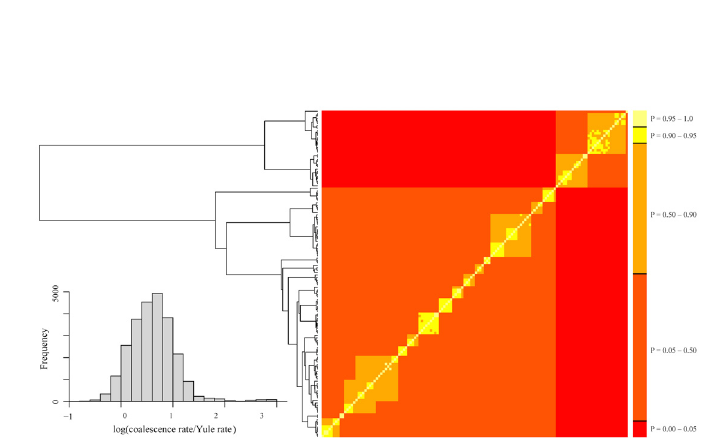
Fig 4. Bayesian maximum clade credibility tree. As with Fig 3, but showing relationships within Clades B-D.